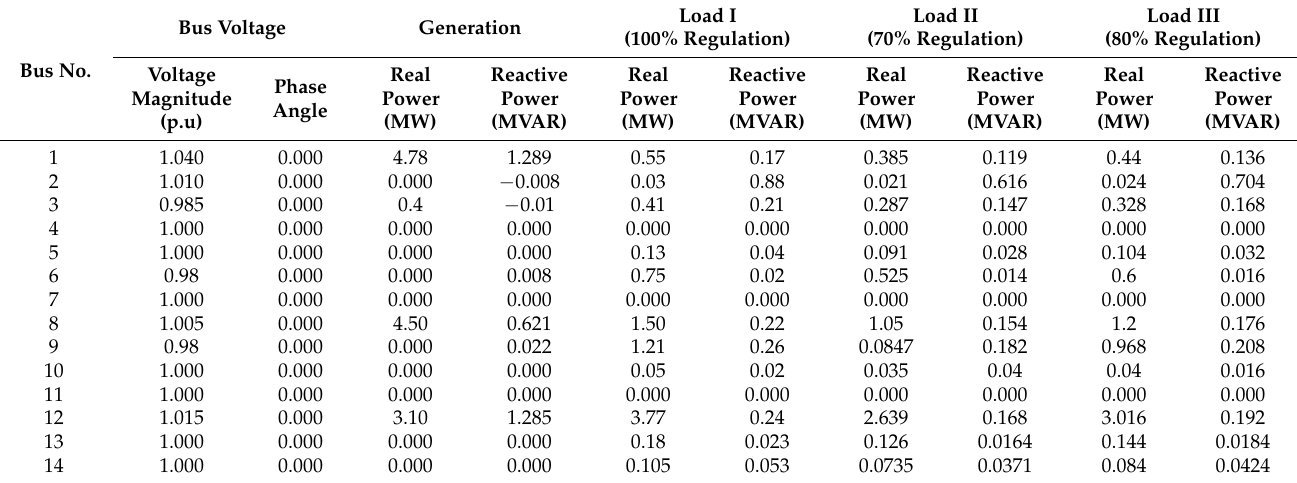
Table 2. Generation and load